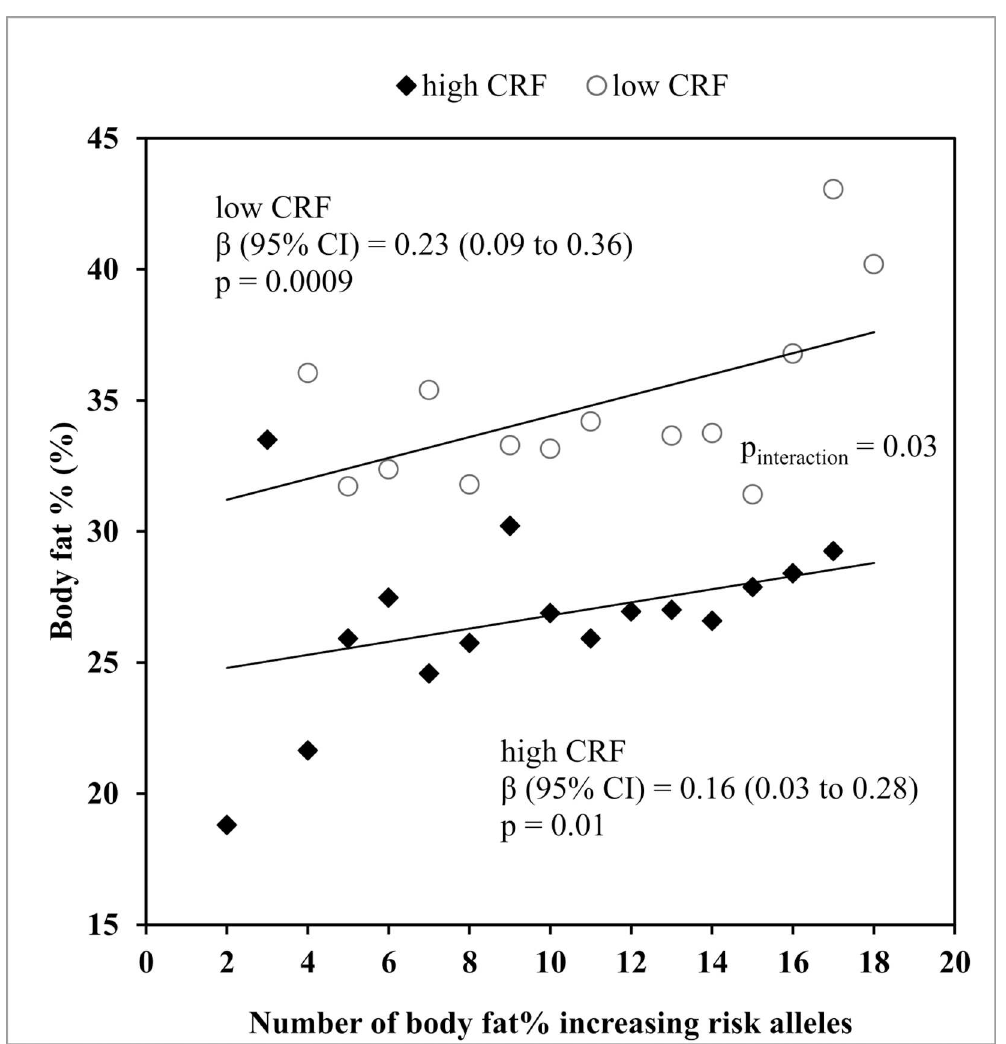
Fig 1. Association between the body fat% GRS and body fat% in the low CRF and high CRF groups after meta-analysis of two Danish cohorts (ADDITION-PRO and Health2006, a total n = 3206). Weightedmean body fat% for each numberof body fat% risk alleleswas calculatedbasedon the relativeweight for each cohort. CRF was objectivelymeasured by step test and the study participants of both cohorts were stratified by the respectivemedianof VO 2 max to form “high CRF” and “low CRF” groups. We tested for body fat% GRS x CRF interaction effects using linear models (P interaction =